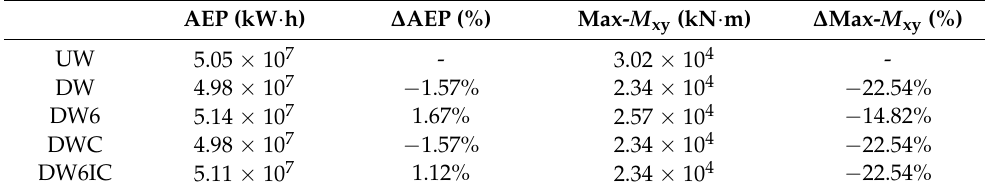
Table 4. Case simulation